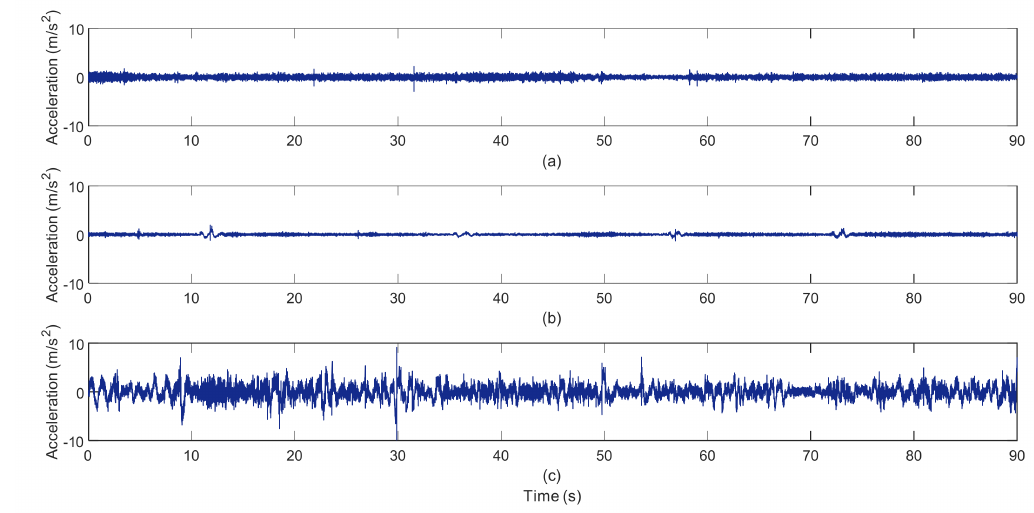
Measured acceleration time histories from different road conditions: ( a ) highway; ( b ) residential; and, ( c ) rural.